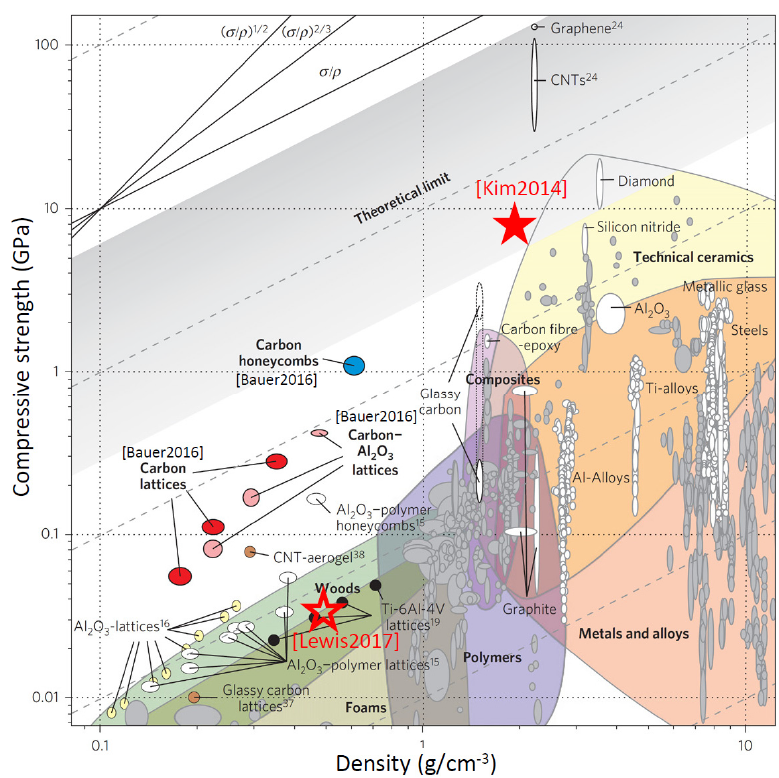
Figure 25. Strength–density scatter plot. The open asterisk denotes the FEBID Pt–C lattice tower structure from Lewis et al. [48] shown in Figure 24 and the full asterisk denotes the Ga–FIBID carbon material from Kim et al. [41] shown in Figure 4f. Modified from Bauer et al. [127] .